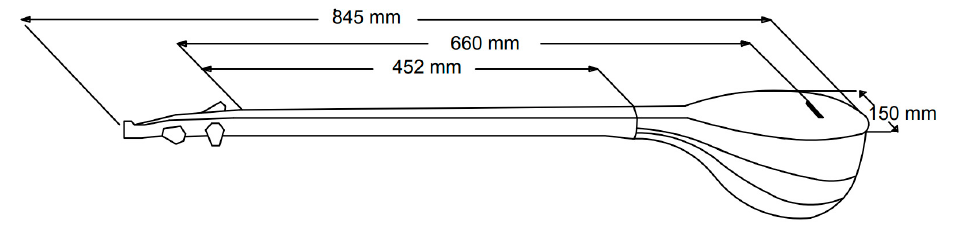
Figure 5. ( a ) Step seven: check the situation, ( b ) the optimized size and location of the sound ‐